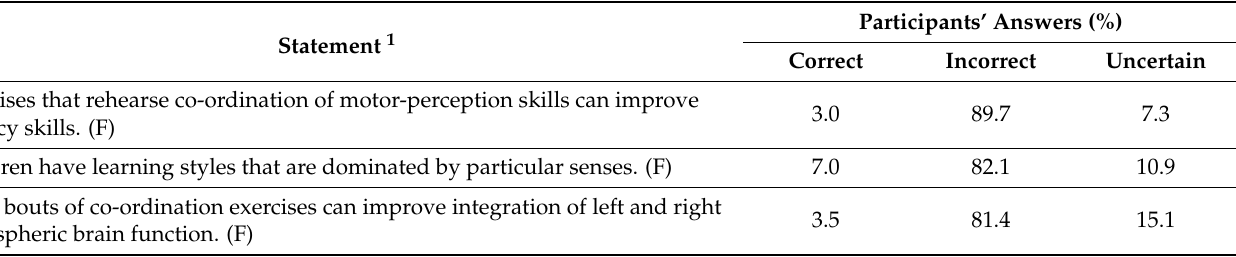
Table 4. Participants’ answers to statements related to educational neuromyths (in descending order of the rate of incorrect